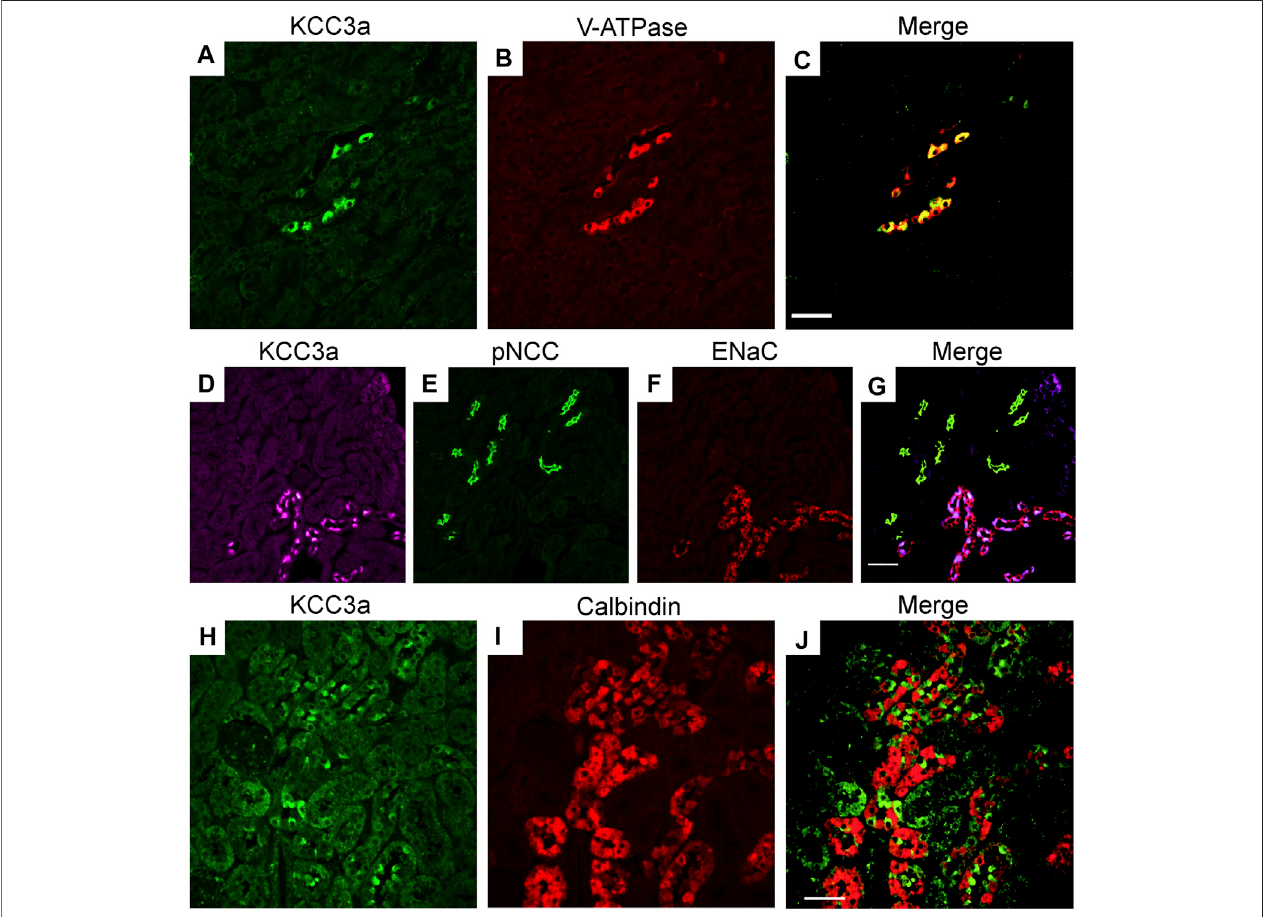
FIGURE 3 | Potassium chloride cotransporter 3a (KCC3a) expression along the connecting tubule. KCC3a expression [green, (A) ] and vacuolar-type ATPase (V-ATPase) expression [red, (B) ] with overlap of signal [yellow, (C) ] in kidney cortex. KCC3a expression [purple, (D) ], phosphorylated sodium chloride cotransporter (pNCC) [green, (E) ], epithelial sodium channels (ENaC) [red, (F) ], and merged signal (G) in the kidney cortex. Expression of KCC3a [green, (H) ], connecting tubule- speci fi c principal cell marker — Calbindin-28 [red, (I) ] and merged image (J) in the renal cortex. The signal for KCC3a is interspersed among the calbindin-positive cells. Scale bar = 50